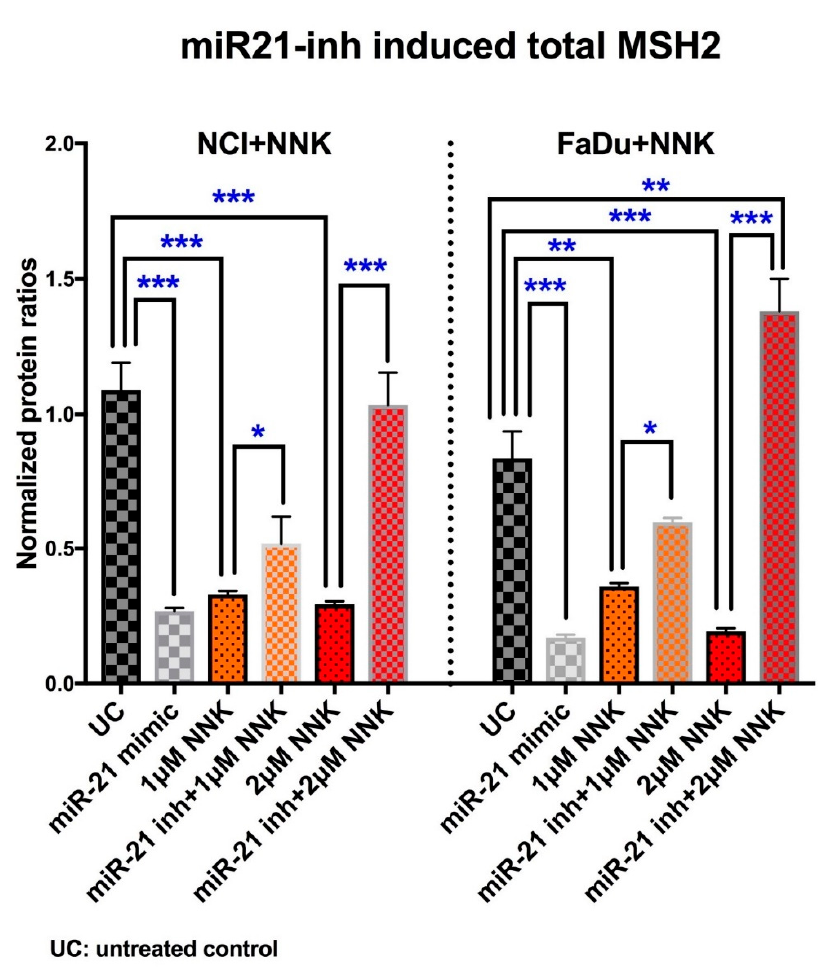
Figure 6. Inhibition of miR-21 prevents NNK-induced MSH2 reduction. Graphs created by GraphPad Prism 7.0 depict total MSH2 protein level in NCI and FaDu exposed to 1 µ M or 2 µ M of NNK, with and without miR-21 inhibitor. Controls: cells treated with mimic miR-21 and untreated controls. (Data obtained from three independent experiments [* p < 0.05; ** p < 0.005; *** p < 0.0005, by t -test; multiple comparisons by Holm-Sidak; GraphPad Prism 7.0; means (SD)].